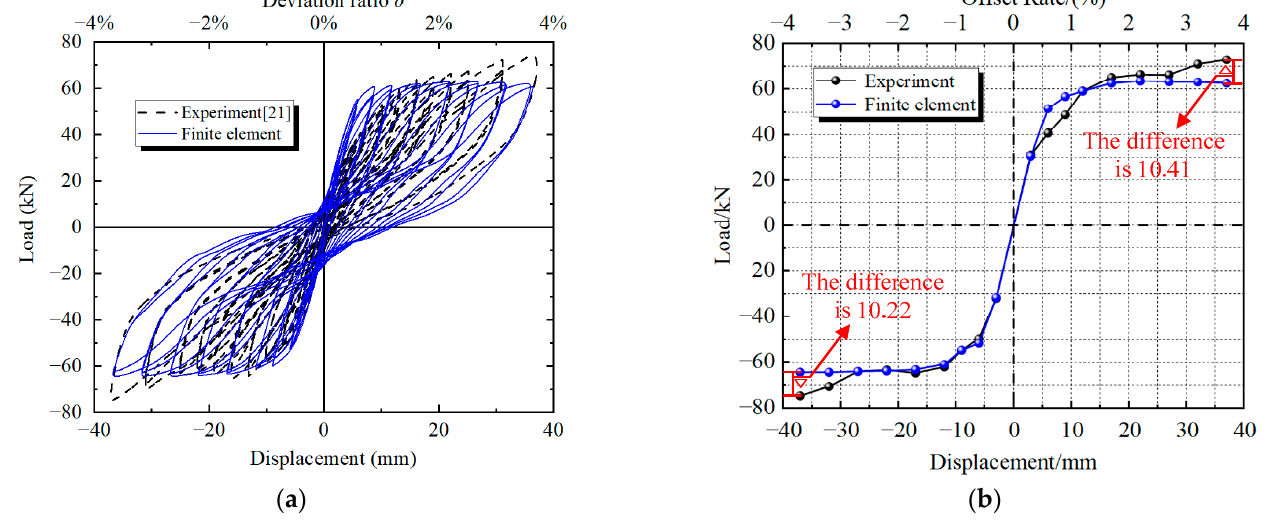
Figure 9. Comparison of hysteresis curves and skeleton curves [20]. ( a ) Hysteresis curve. ( b ) Skeleton curve.